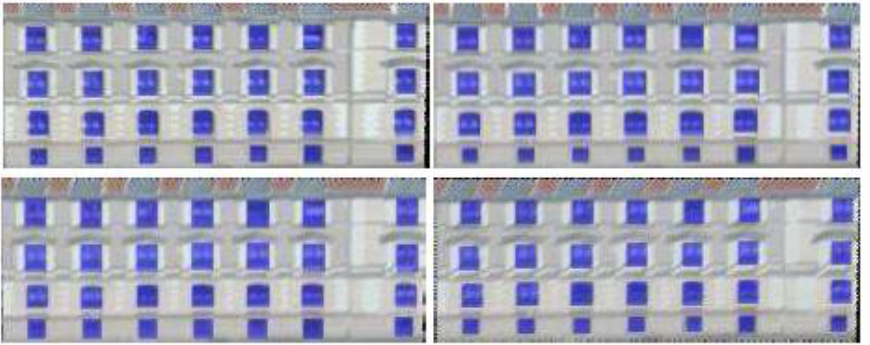
Figure 15. Four images on one facade from Figure 12 lead to independent floor and window counts. It is to be noted that the floor counts and the number of windows concur with the visual